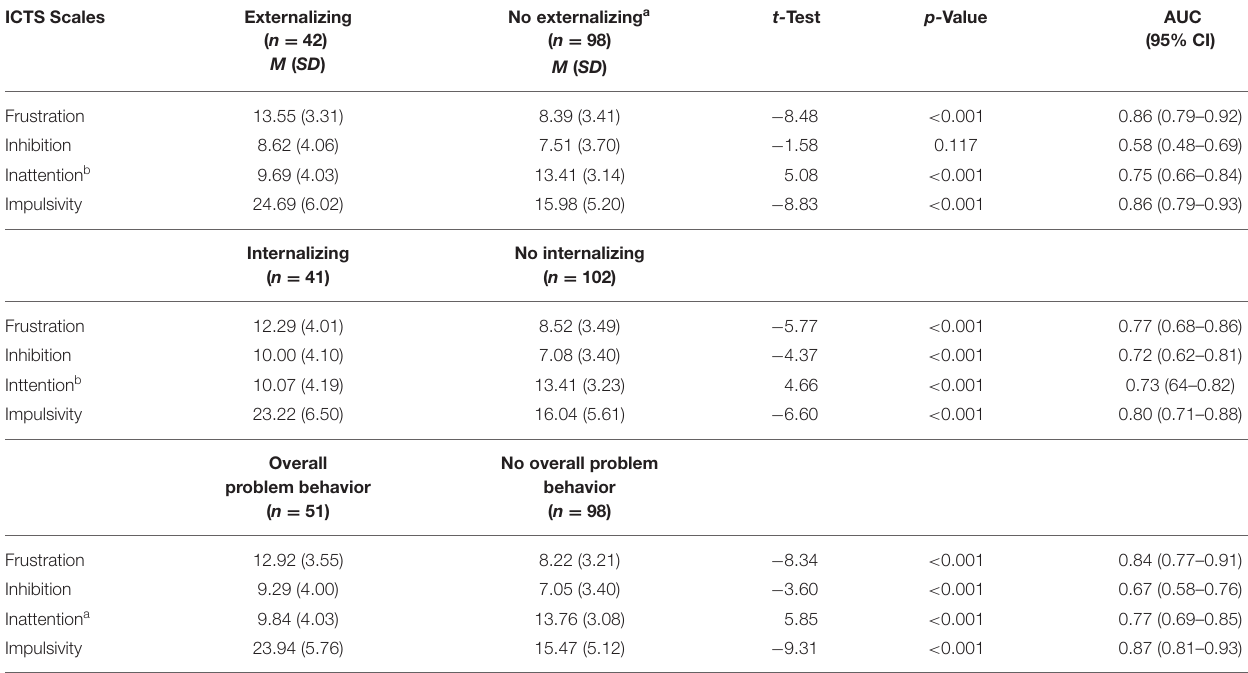
TABLE 6 | t -Test comparisons and area under the curve of ICTS scales for children at risk and at no risk for externalizing, internalizing, and total problems according to the CBCL. ICTS